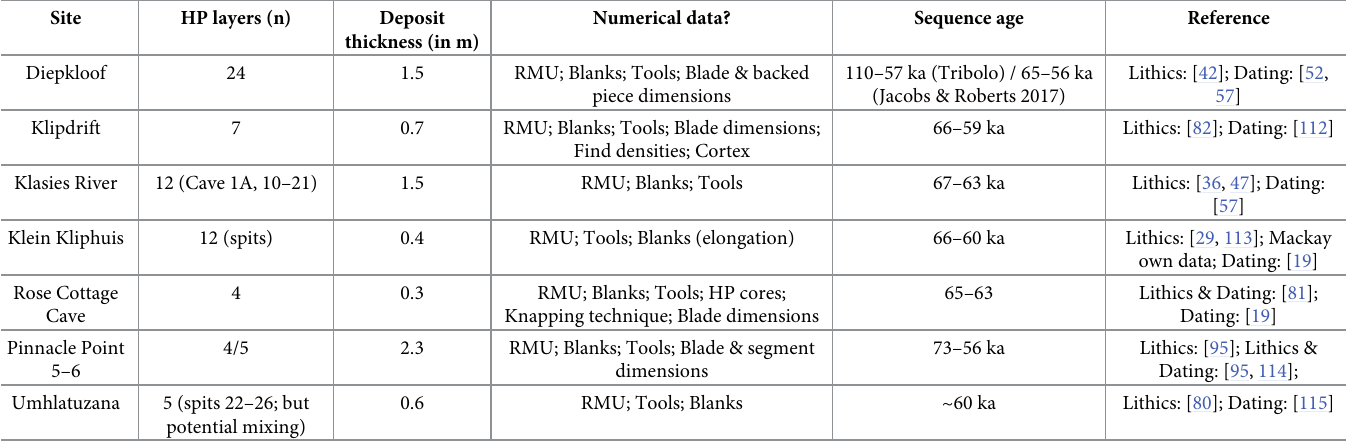
Table 8. Overview of HP sites used for the comparative quantitative study with reference to sources of the numerical lithic data and absolute dating. Site